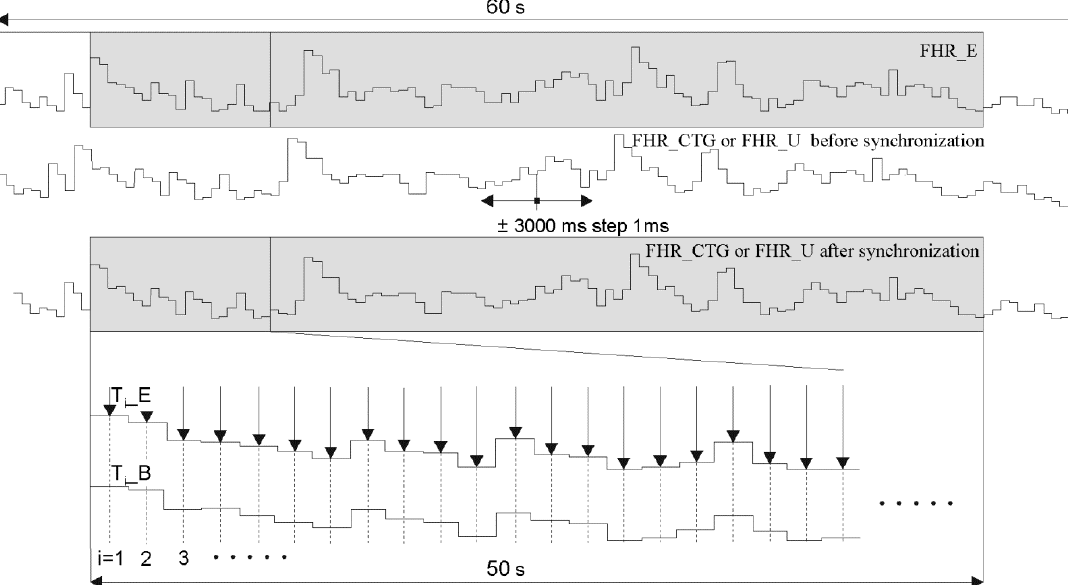
Figure 10. Synchronization procedure of the fetal heart rate signals: FHR_E—obtained from the reference direct FECG, FHR_U—determined by one of the methods based on a raw Doppler US signal and FHR_CTG—acquired directly from a fetal monitor output.